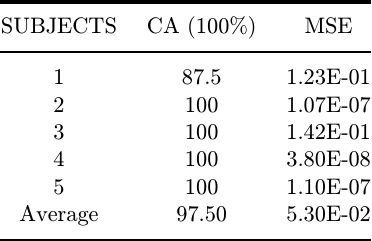
Table 4. List of individual classi¯ca- tion accuracies with MSE for partici- pated subjects.